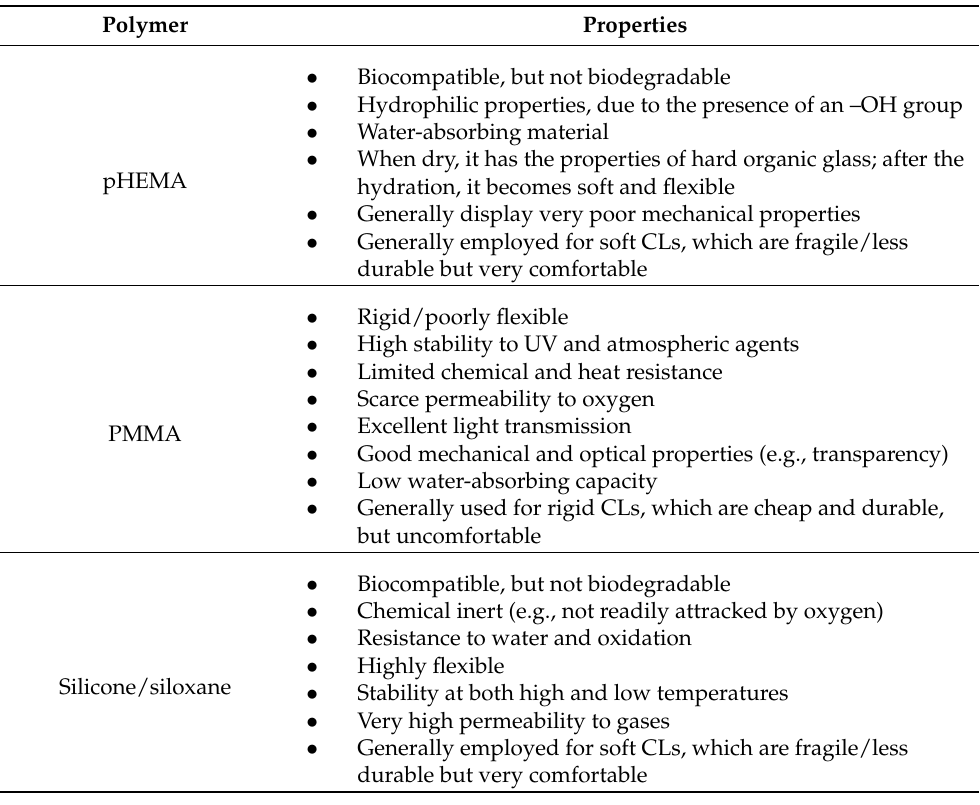
Table 1. A list of the polymers mainly employed to prepare therapeutic Contact Lenses